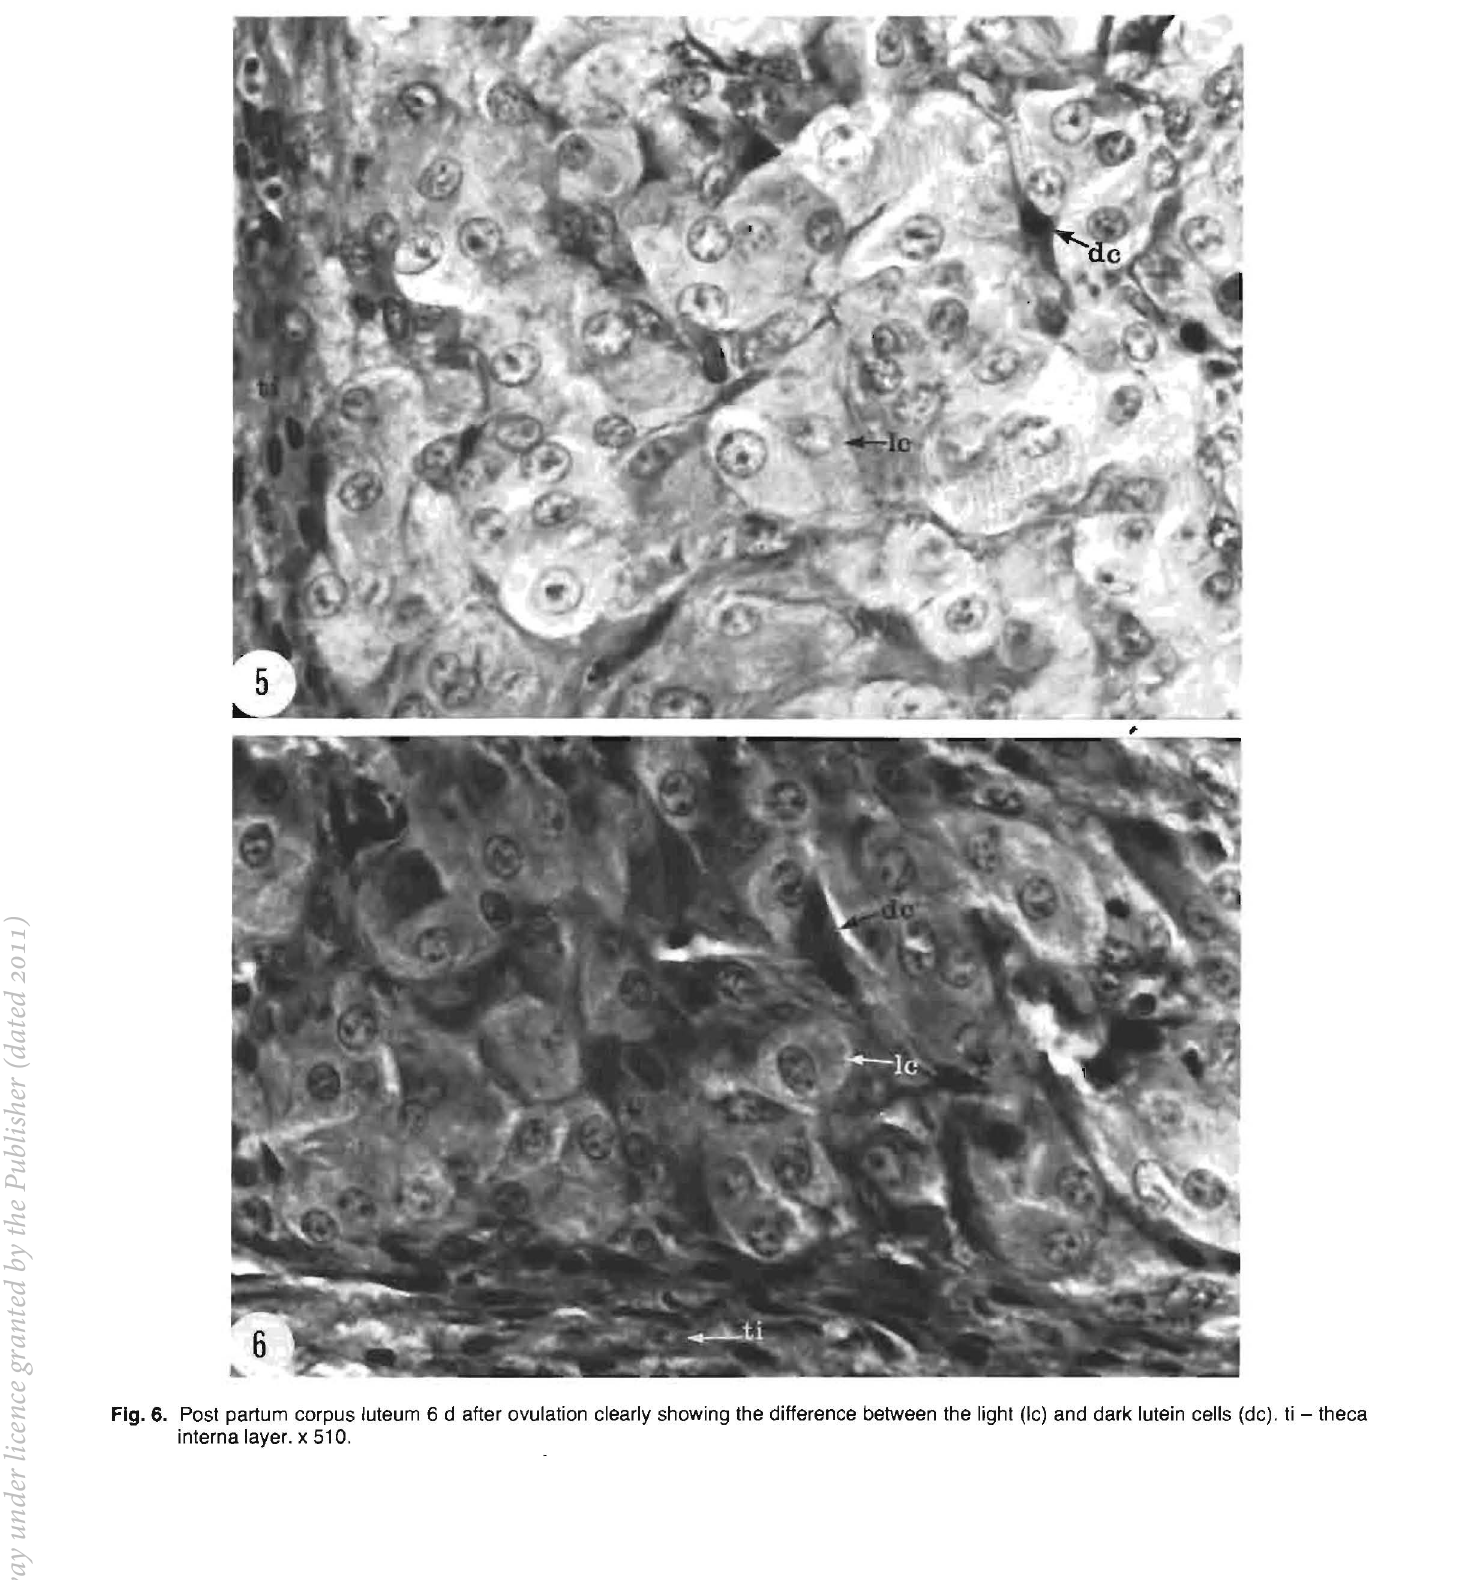
Relationship between the morphology of and progesterone pro duction by the corpus luteum of the mare. Journal of Reproduc tion and Fertility 23: 171-175 6. Corner G W 1919 On the origin of the corpus luteum of the